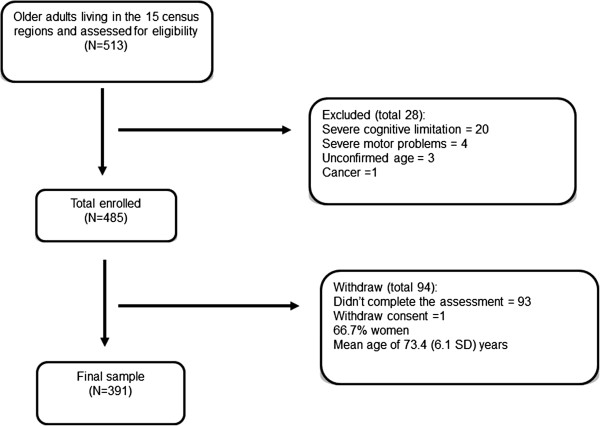
Flowchart of the study sample.